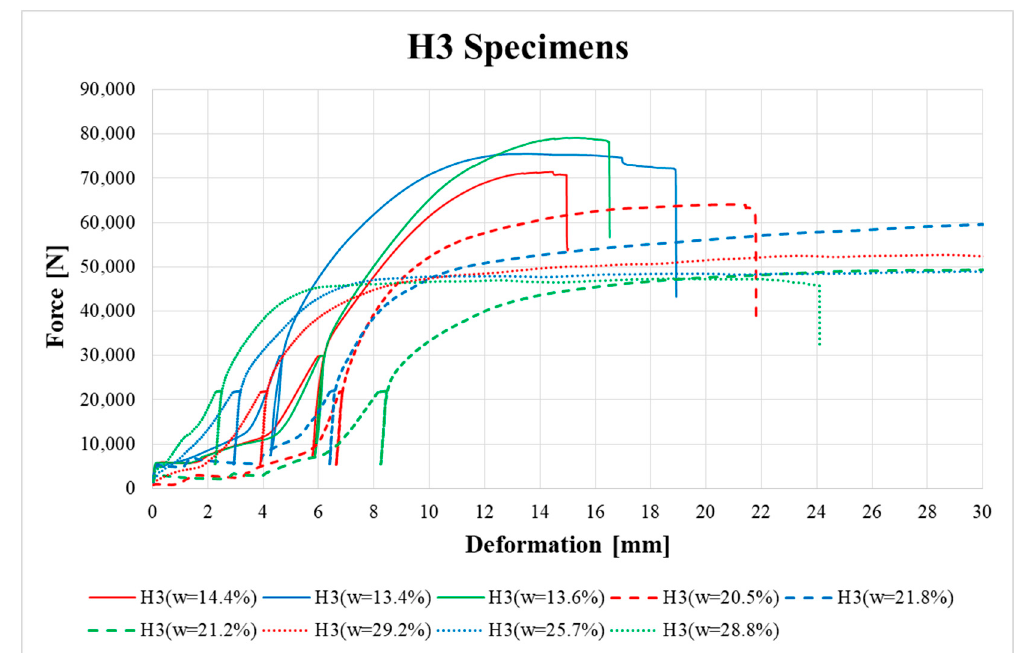
Figure 10. Load–deformation curves of H2 specimens.